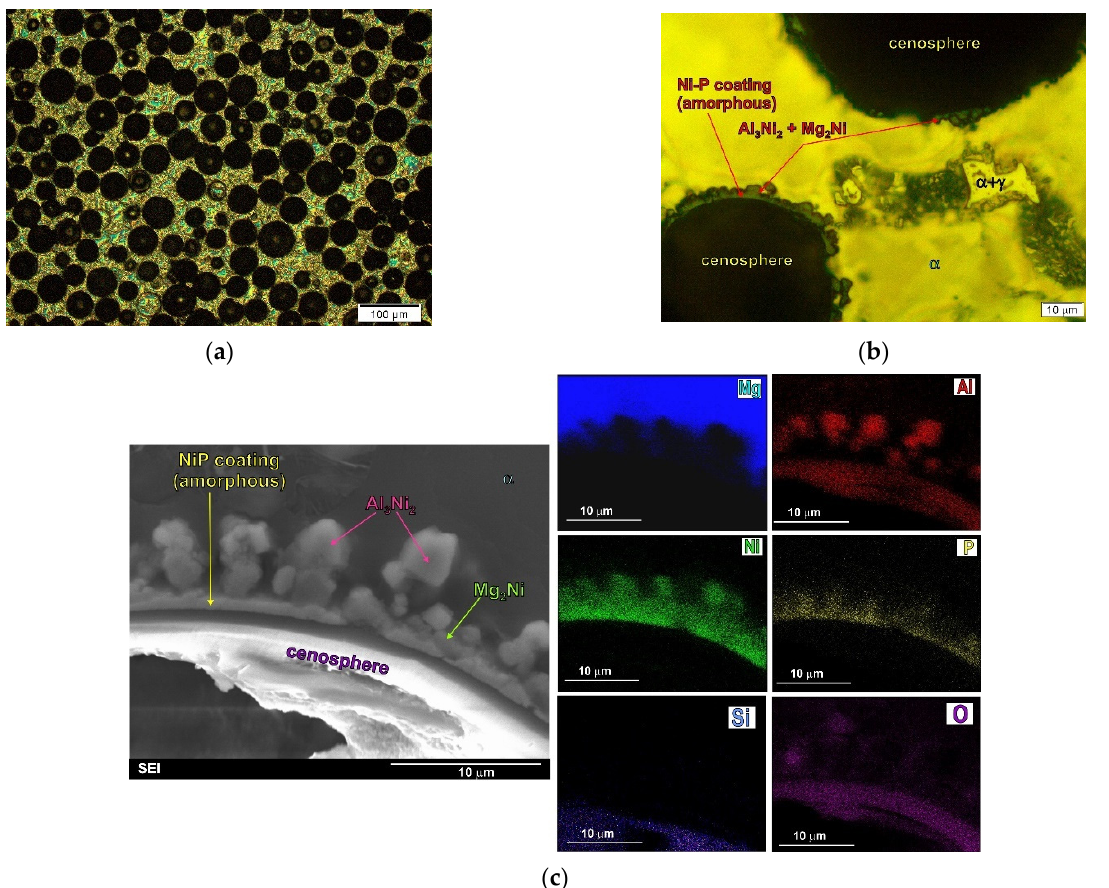
Figure 9. Microstructure of AZ91 magnesium matrix composites with Ni-P coated aluminosilicate cenospheres. ( a , b ) Micrographs taken at different magnification; ( c ) SEM micrograph of composite microstructure with EXD results.